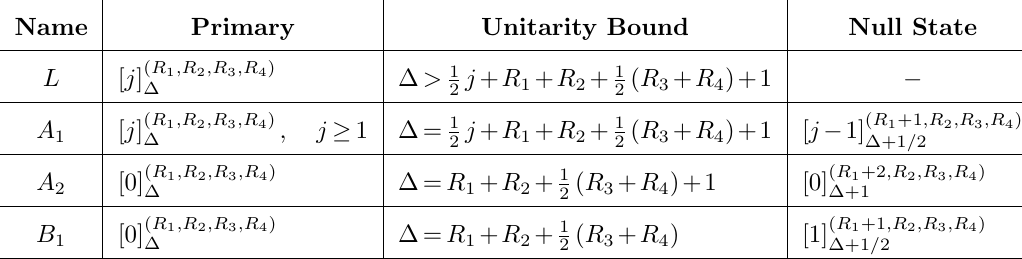
Table 9 . Shortening conditions in three-dimensional N = 8